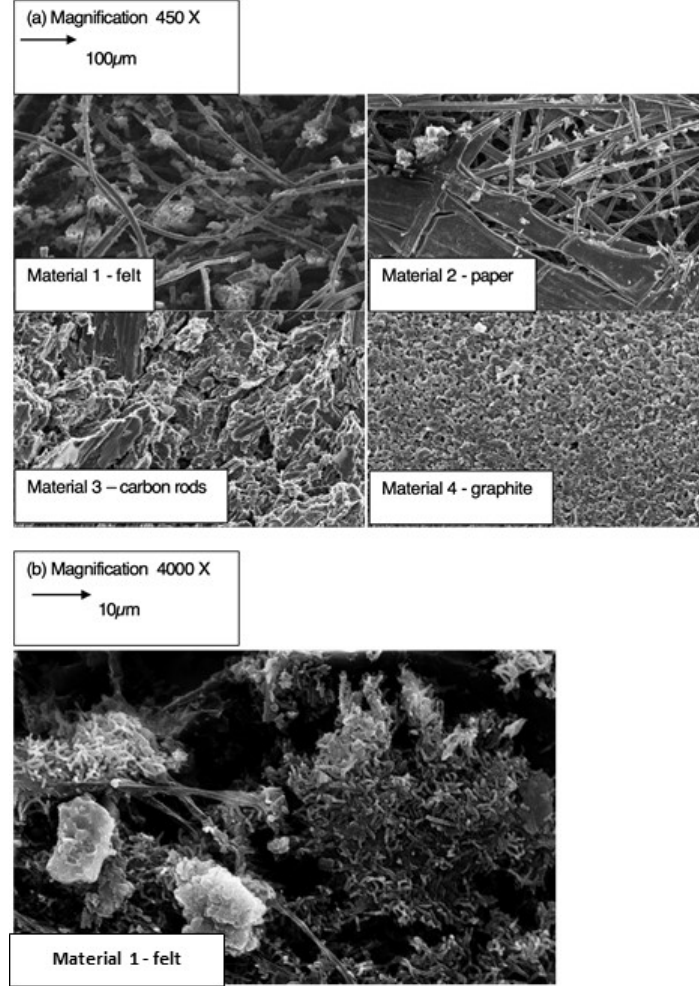
Figure 3. SEM pictures showing biofilm build-up and microbial growth on different test carbon materials: ( a ) 450 × and ( b ) 4000 × magnification (carbon felt).